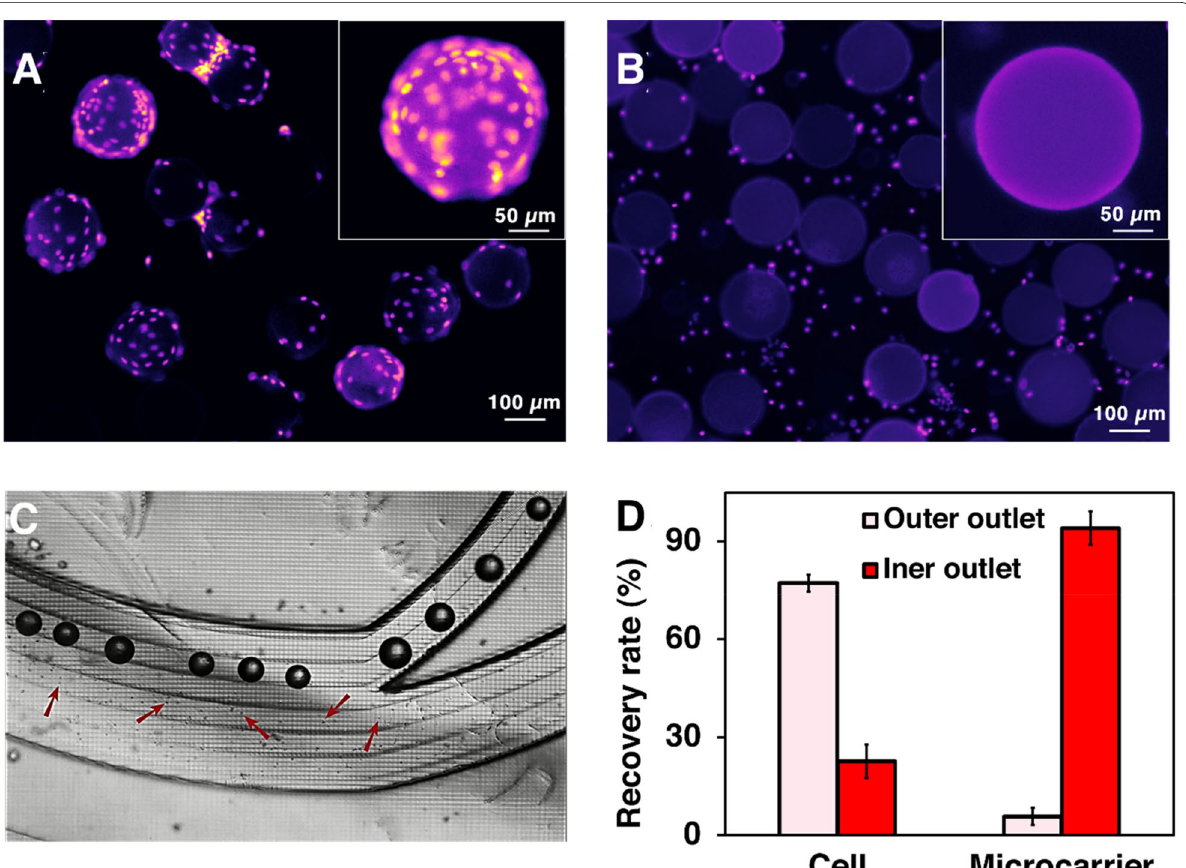
Fig. 3 Harvesting MSCs with our microfluidic system. The concentrating efficiency of the zig-zag channel is shown in Additional file 1: Fig. S9. A and B Fluorescent microscopy images of cells–MCs before and after passing through the mixer. Cell nuclides were stained with Hoechst. C Separation of cells and microcarriers through the spiral chip. Cells and MCs were separated through different channels based on their size difference. D The recovery rate of cells and MCs after passing through the spiral chip in one round. The liquid collected from the inner outlet of the spiral was collected and performed a second-round running through to further recover the cells. The two-round separation results are shown in Additional file 1: Fig.